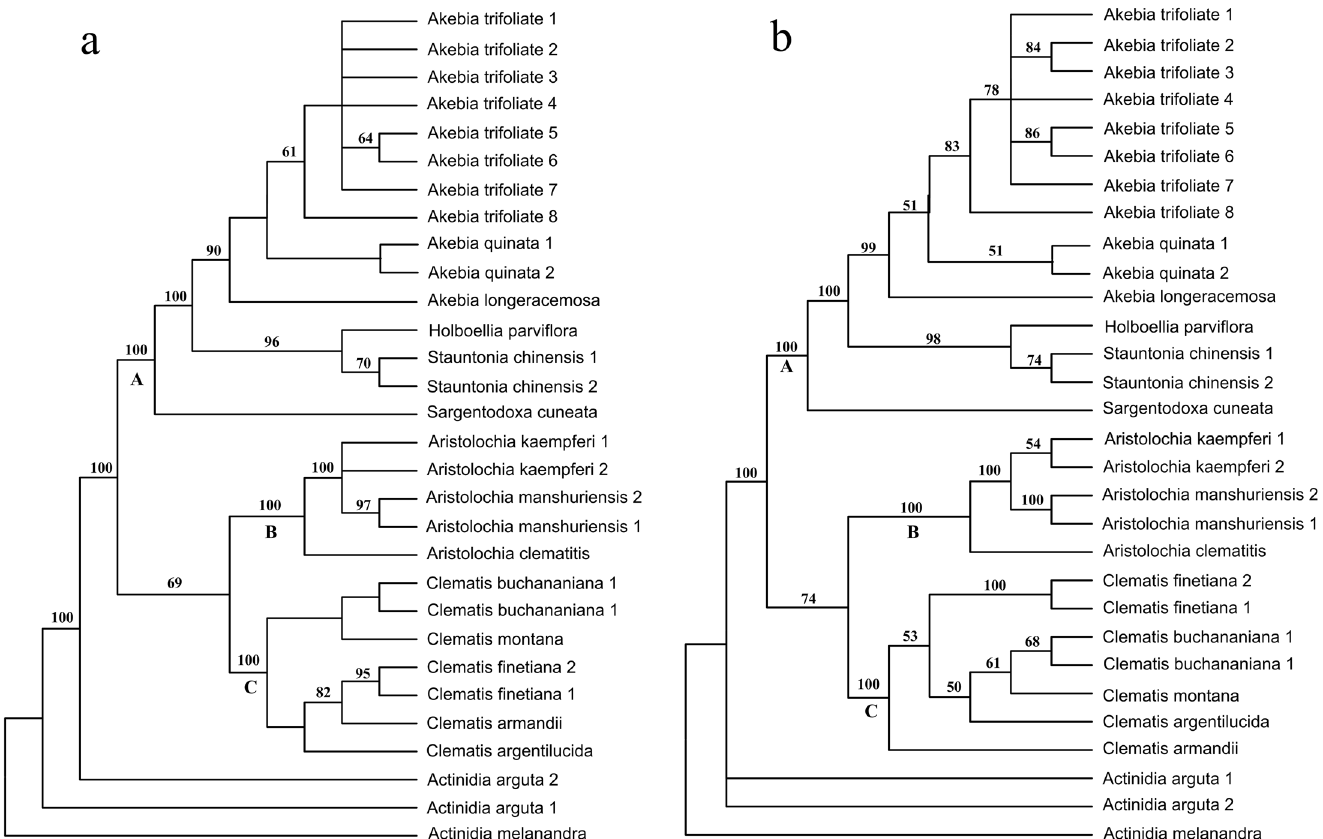
Fig 4. Comparison of MP trees inferred from different data sets. a. MP tree inferred from secondary structure coding information; b. MP tree inferred from the combined nucleotide sequences and secondary structure information. Numbers on the branches indicate the bootstrap values of MP above 50%, numbers following a species name represent individual